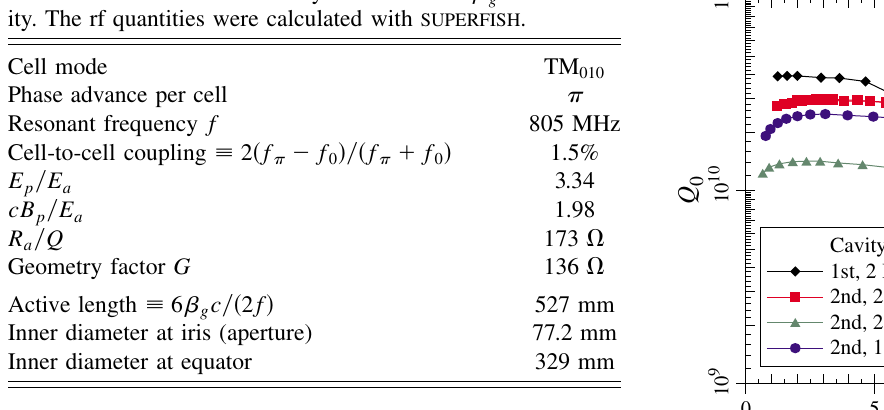
(cid:7) 0 : 47 cav- g